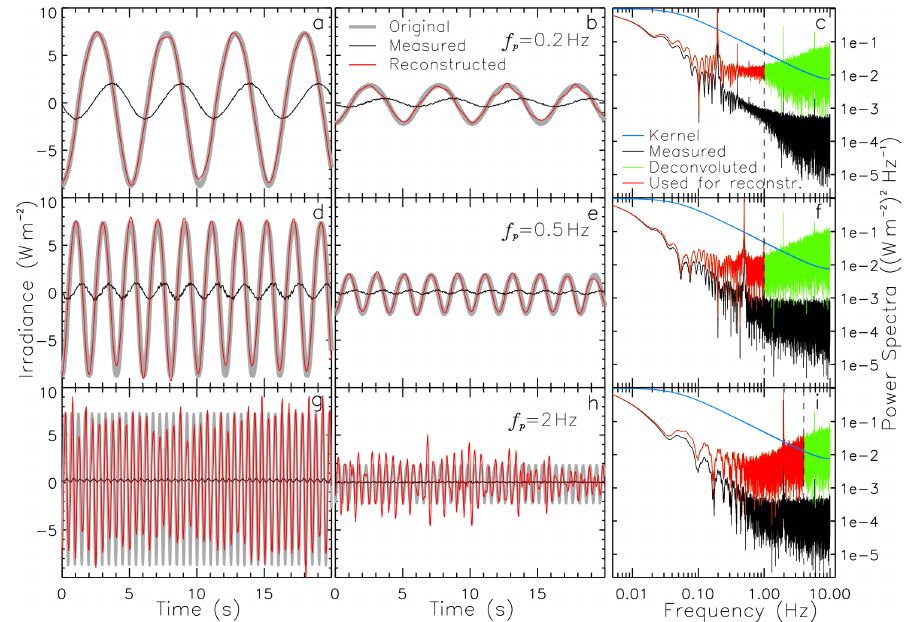
Figure 5. Measured (black) and reconstructed irradiance (red) in case of a periodic oscillating time series (gray) for three different frequencies of the oscillation f p = 0.2/0.5/2Hz. Oscillations with two different amplitude were generated, 8Wm − 2 amplitude in the left panels ( a , d and g ) and 2Wm − 2 amplitude in the center panels ( b , e and h ). The corresponding power spectra for the measured (black), deconvoluted (green) and reconstructed time series (red) as well as the convolution kernel (blue) are given in ( c , f , and i ).